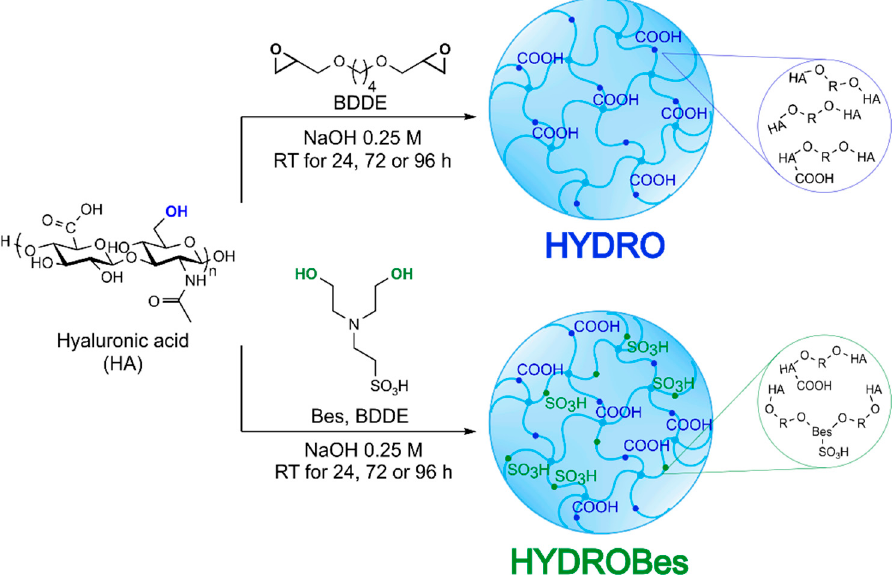
Figure 1. Scheme of synthetic conditions used for the preparation of hydrogel with BDDE (HYDRO) and BDDE/Bes (HYDRO-Bes), together with a schematic illustration of expected hydrogels (R = crosslinker). The HYDRO-Bes gels are enriched in -SO 3 H functionalities. Functional groups involved in the crosslinking/sulfonation reaction are evidenced.